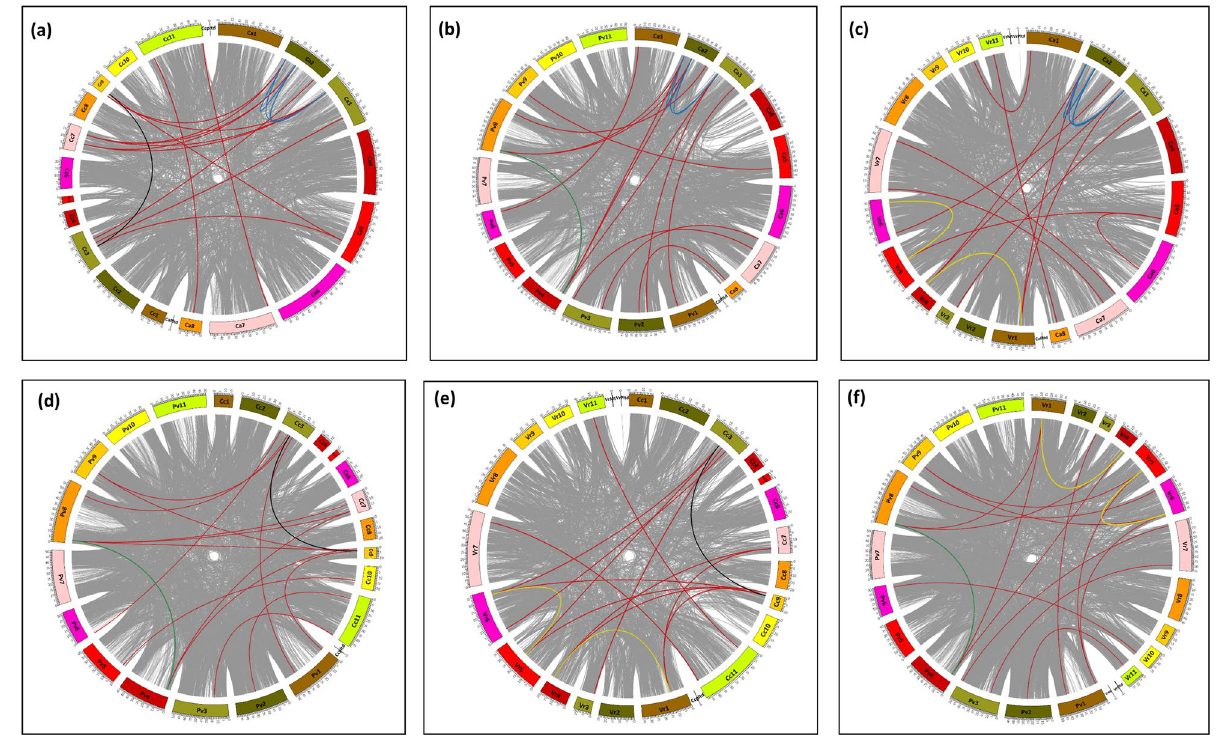
Figure 3. Segmental duplicated gene pairs in OSCAs between, ( a ) C. arietinum and C. cajan, ( b ) C. arietinum and P. vulgaris, ( c ) C. arietinum and V. radiata, ( d ) C. cajan and P. vulgaris, ( e ) C. cajan and V. radiata, ( f ) P. vulgaris and V. radiata. The red lines denote the interspecific gene pairs. The intraspecific duplicated gene pairs are denoted by blue in C. arietinum, black in C. cajan, yellow in V. radiata and green in P. vulgaris . The size of each chromosome (Mb) is resembled by the size of the corresponding